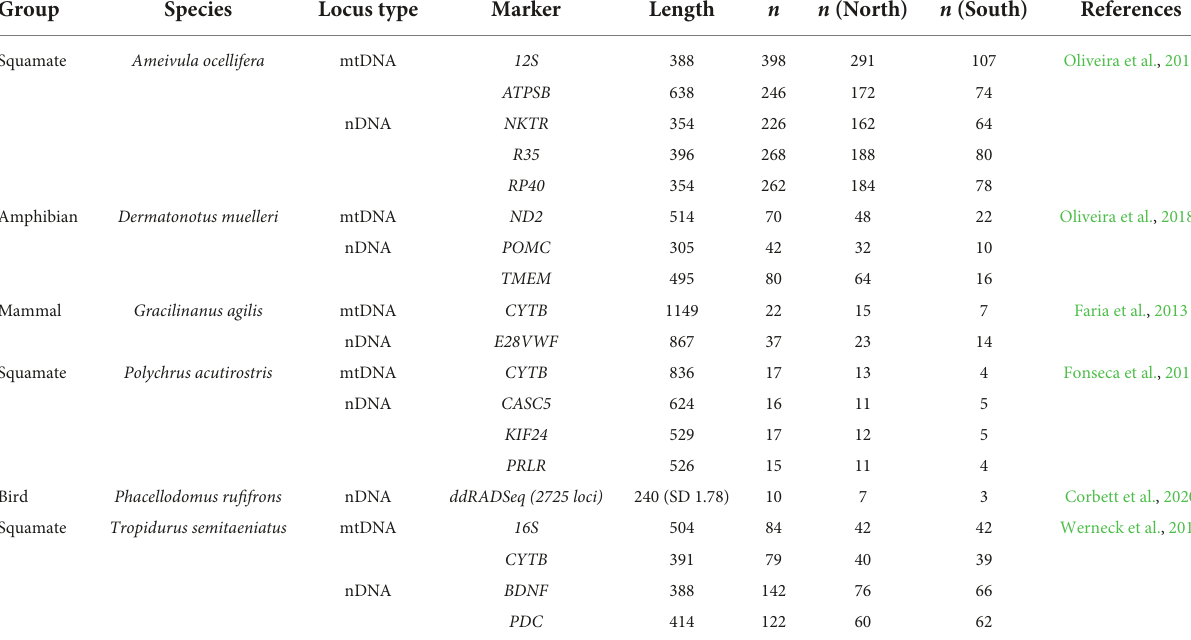
TABLE 1 Species, genetic markers, and sequence counts used to test the São Francisco River Hypothesis (SFRH). Group